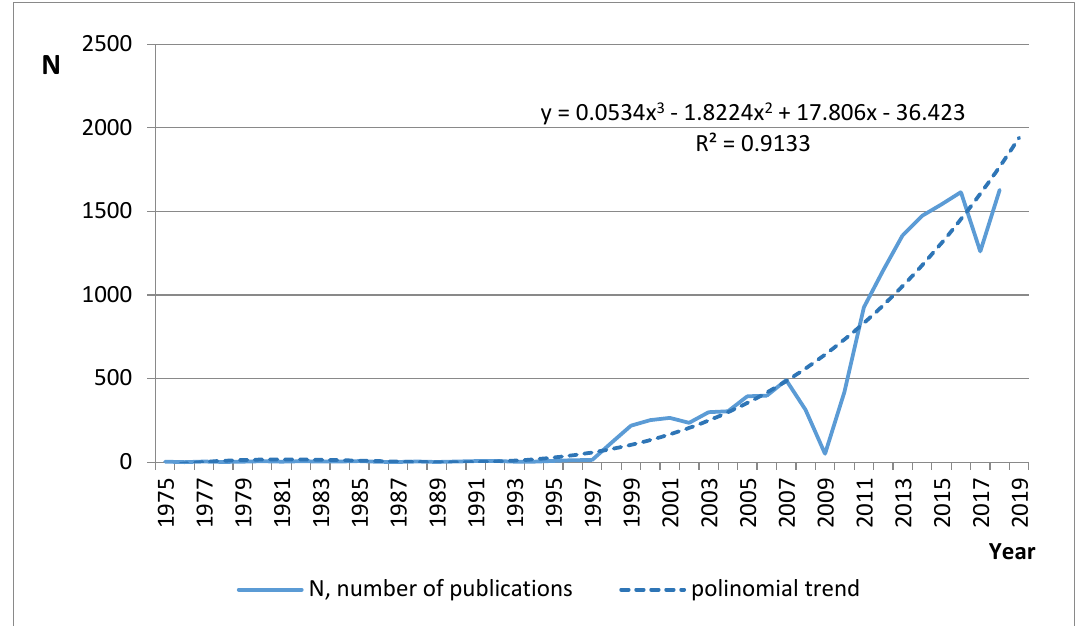
Figure 4. The trend of publication activity from 1975 to 2018 and forecast for the future.